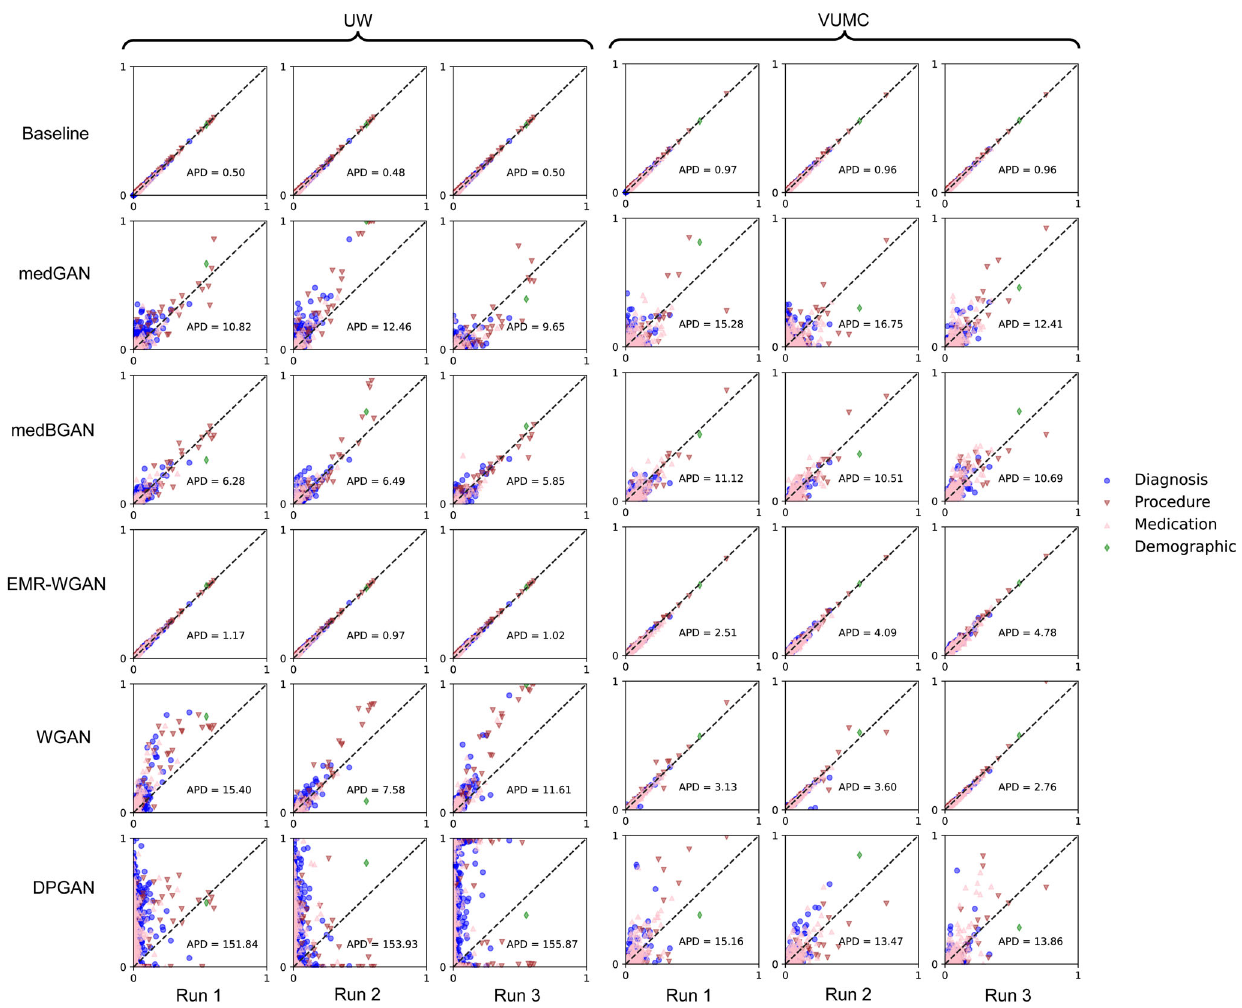
Fig. 2 | Dimension-wisedistributionfor theUWand VUMC datasets. Here, each dotcorrespondstoafeature,andthe x -and y -axescorrespondtotheprevalenceof a feature in real and synthetic data, respectively. The results for three